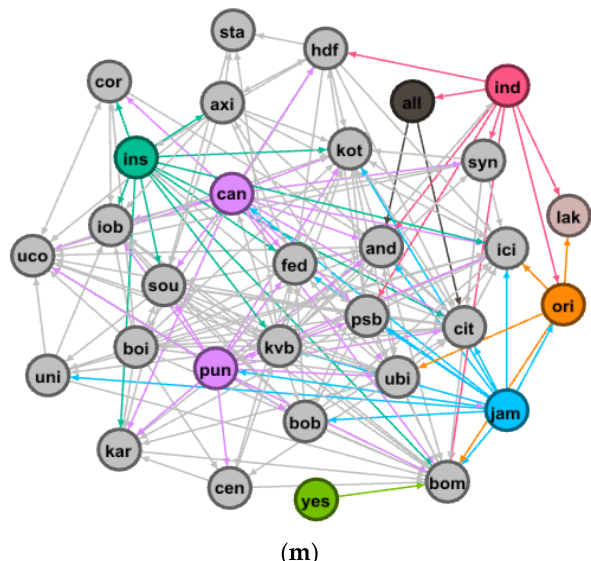
Figure 1. Interbank network structure for banks in India. ( a – m ) represents network structure for the year 2008, 2009, 2010, 2011, 2012, 2014, 2015, 2016, 2017, 2018, 2019, and 2020, respectively. Source: Authors’ own contribution.